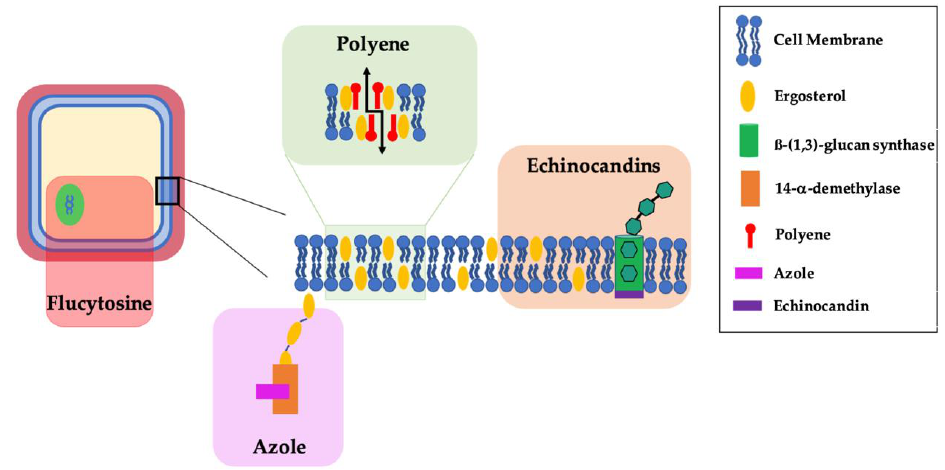
Figure 1. Site of action of currently available antifungal treatments.